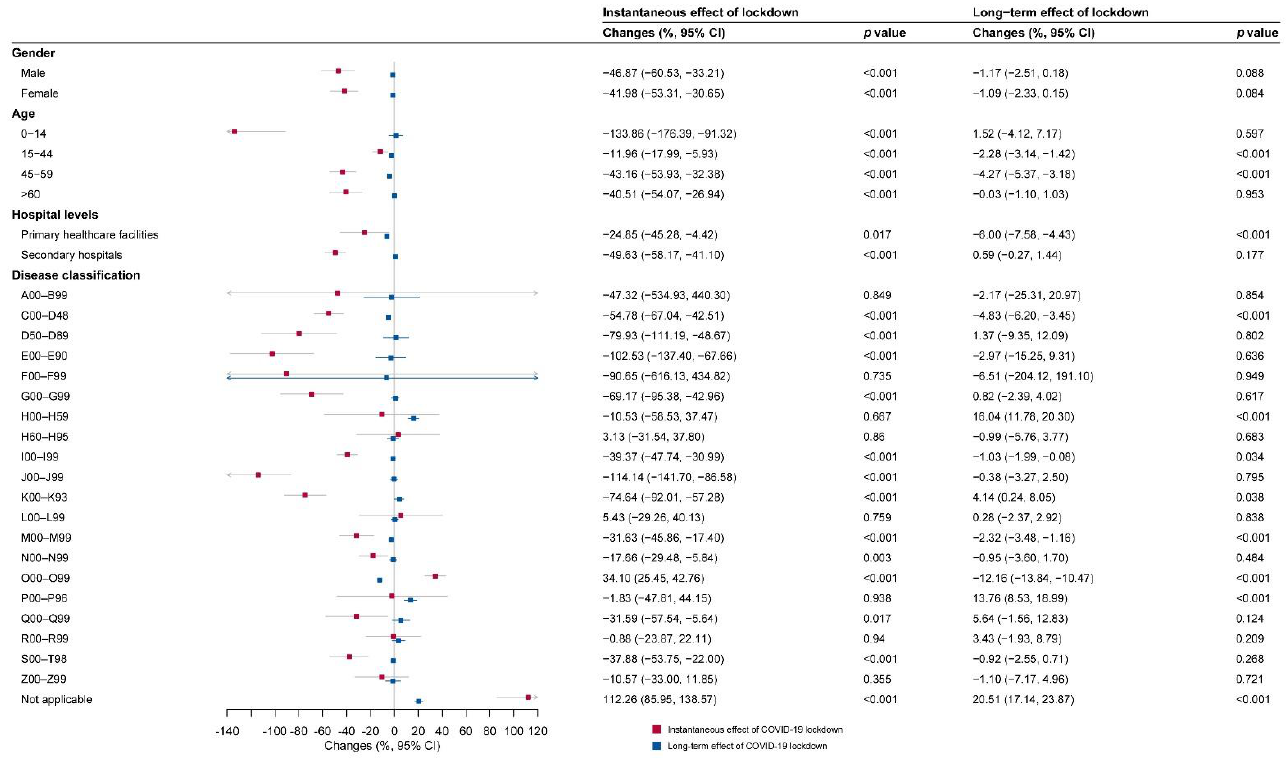
Figure 5. The instantaneous and long-term effect of COVID-19 lockdown on hospital visits